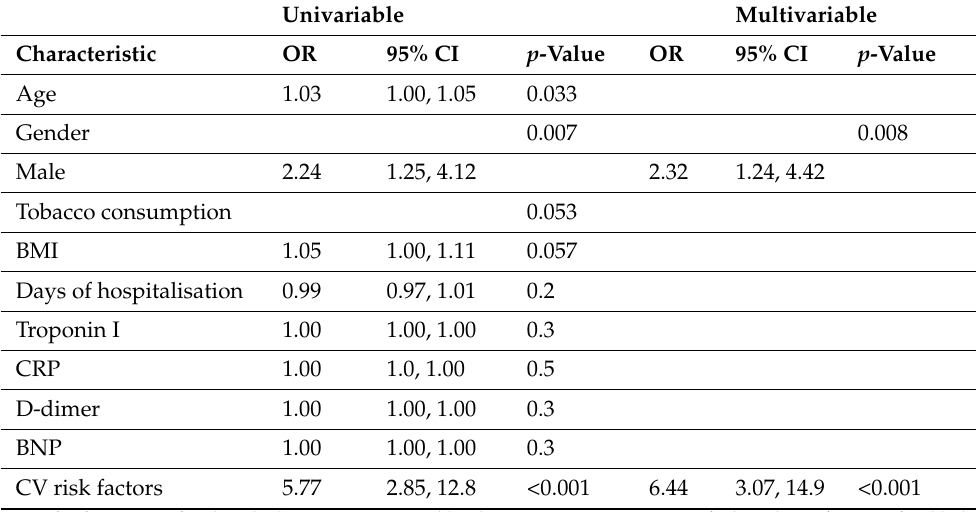
Table 4. Acute predictors of left ventricular subclinical dysfunction.